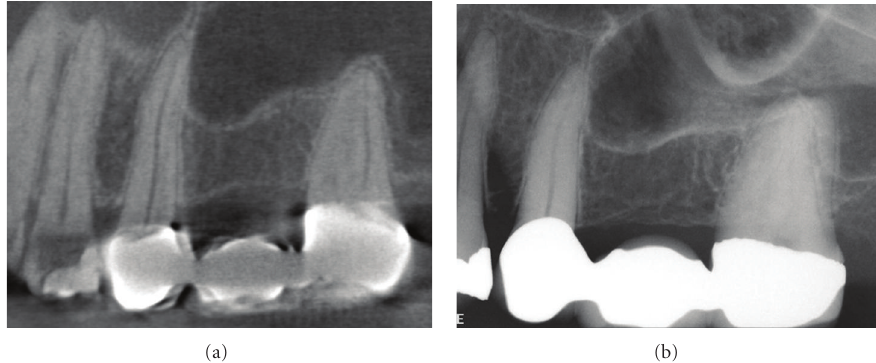
Figure 6: A female patient presented with a twenty-year history of mostly continuous, unilateral, poorly localized severe aching of the maxillary left quadrant. The pain was not associated with sensory loss or other physical signs and pulp tests, and conventional imaging studies were within normal limits. Clinically there was no cessation of pain after administration of local anesthetic. This neuropathic pain syndrome, initially termed atypical facial pain, is more recently known as persistent idiopathic facial pain (PIFP). PIFP refers to pain along the territory of the trigeminal nerve that does not fit the classic presentation of other cranial neuralgias. Diagnostically challenging, PIFP is frequently misdiagnosed and is often attributed by patients to dental procedures, facial trauma, and rarely, by some clinicians, as Neuralgia- Inducing Cavitational Osteonecrosis (NICO). Dynamic visualization of sequential curved planar parasagittal CBCT-reformatted images at 0.076 mm thickness (a) confirmed the absence of obvious pathosis of odontogenic origin as diagnosed from the original intraoral periapical of the region (b). Note the radiolucent area within the coronal portion of the first molar under the radiopaque disto-occlusal restorative material; this represents a streak artifact due to “photostarvation” in the horizontal plane due to the attenuation of adjacent amalgam and radiopaque material and subsequent reduction in available data for image reconstruction. A negative CBCT imaging finding is often very reassuring for these unfortunate patients who often question a nonodontogenic diagnosis. Psychiatric symptoms of depression and anxiety are prevalent in this population and compound the diagnostic conundrum.